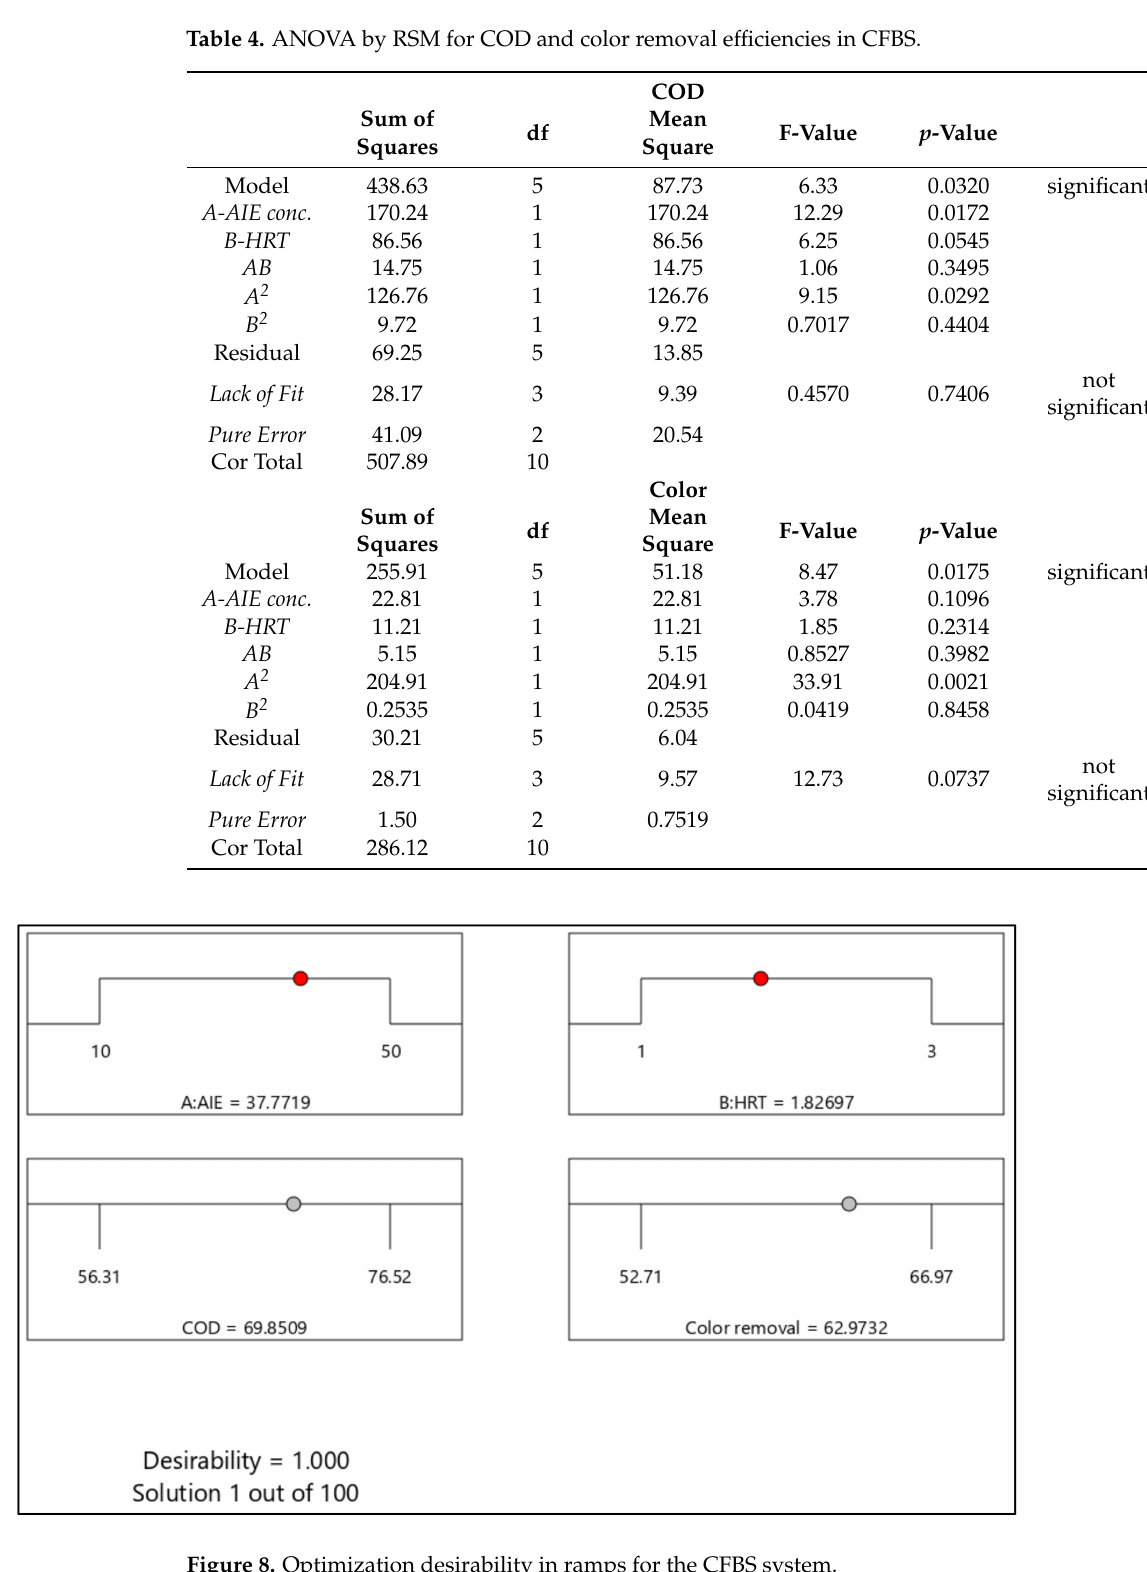
Figure 8. Optimization desirability in ramps for the CFBS